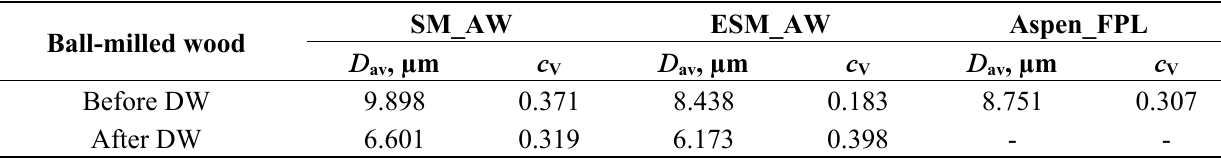
Table 2. Average particle diameter ( D 96:4 dioxane:water (DW) extraction. c Products